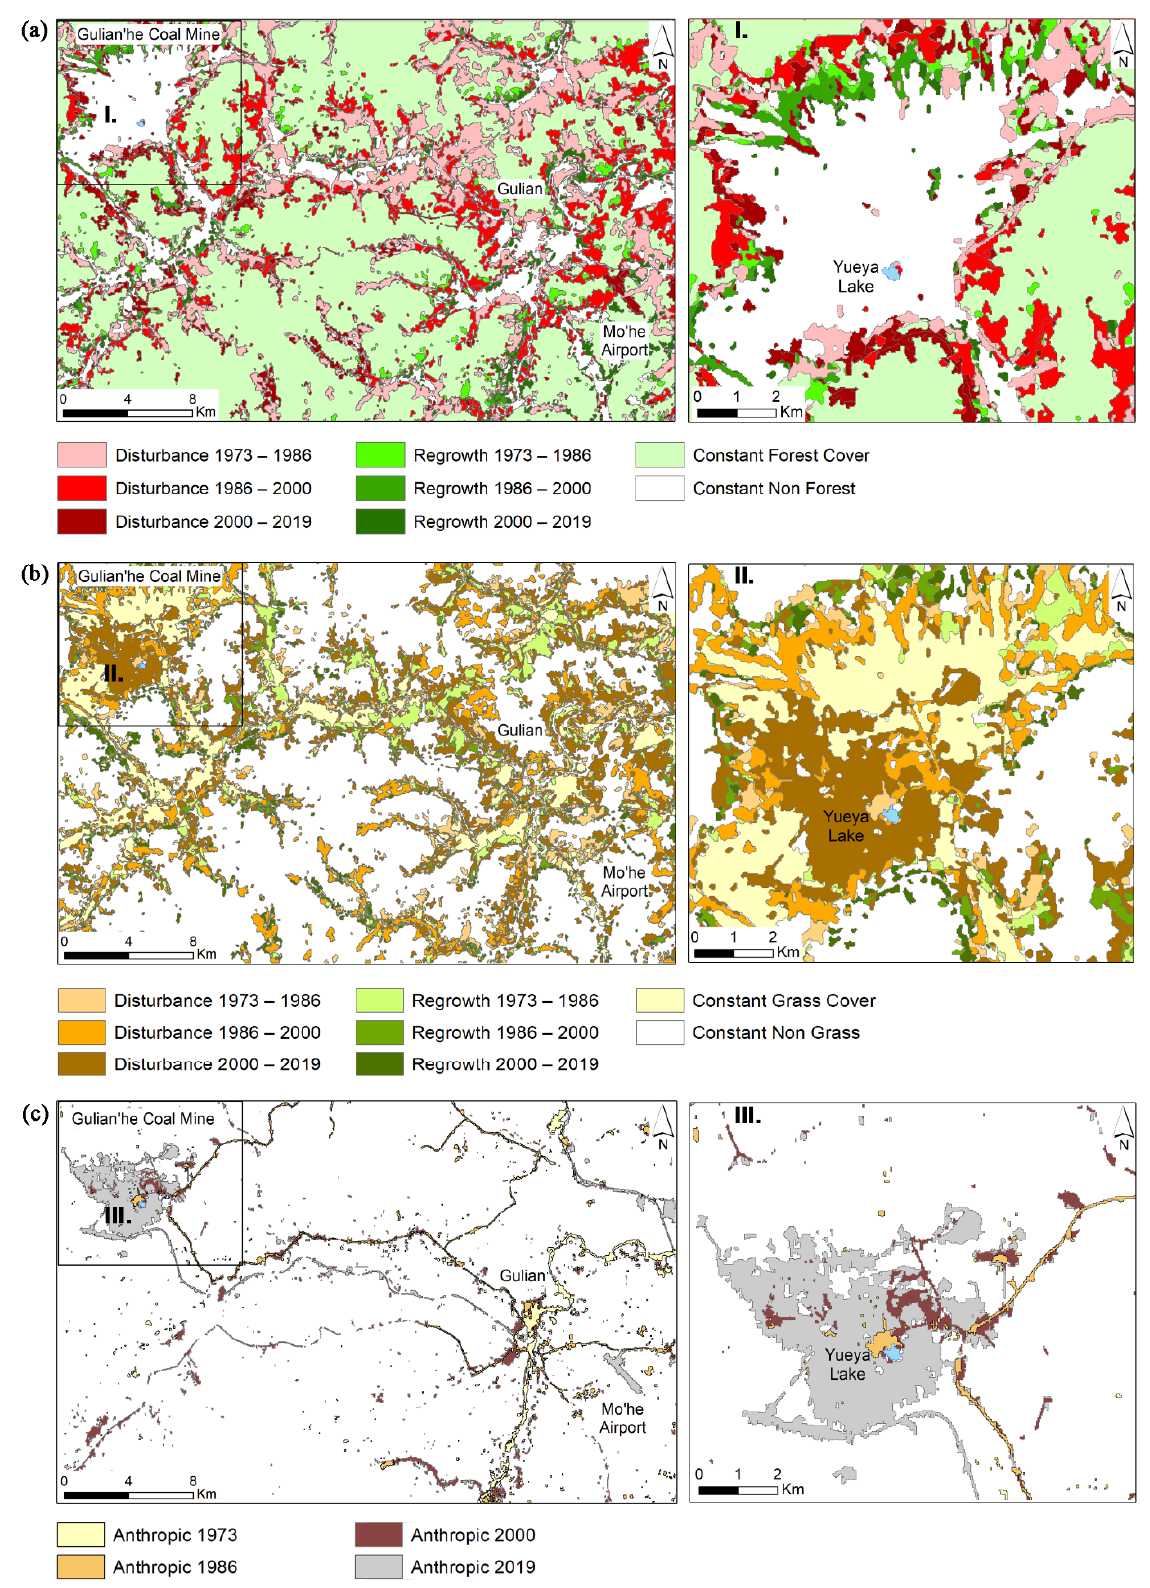
Figure 4. Change maps for the period 1973–2019 in the Hola Basin, Northeast China, for ( a ) forest cover, ( b ) grass cover, and ( c ) anthropic development. I to III are insets of a zoomed view of the Yueya Lake and the Gulian’he coal mine.